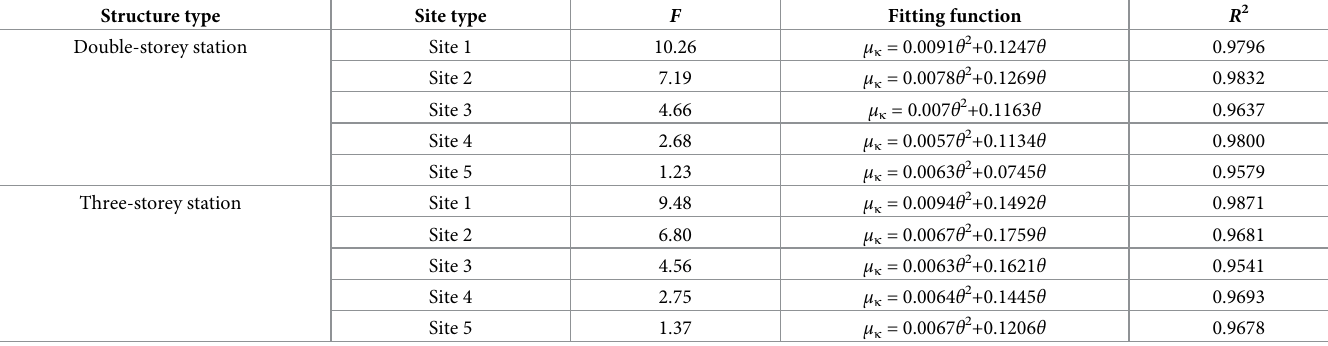
Table 5. Fitting functions of the bending deformation at the sidewall’s bottom section. Structure